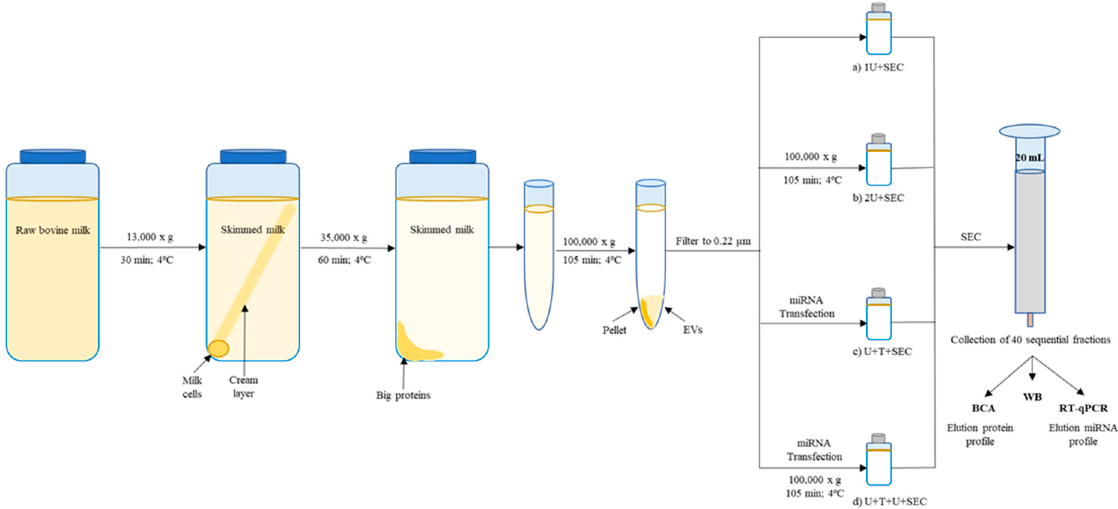
Figure 6. Summary of the EV isolation approaches. Raw bovine milk was skimmed by differential centrifugation to remove cells, fat globules and large proteins. Ultracentrifugation of 25 mL of skimmed milk (SM) results in a solid pellet containing most of the SM casein, a supernatant of milk serum, and a viscous phospholipid rich soluble concentrate positioned adjacent to the casein pellet containing EVs (called fluffy layer). EV fluffy layers were filtered through 0.22 µ m syringe filters. Afterwards, 700 µ L of filtered EVs were enriched through two different approaches: ( a ) SEC (1U + SEC) or ( b ) additional ultracentrifugation followed by SEC (2U + SEC). After first ultracentrifugation, EVs loaded with exogenous miRNA by the transfection method were then isolated by ( c ) SEC (U + T + SEC) or ( d ) additional ultracentrifugation followed by SEC (U + T + U + SEC). Forty sequential fractions of 500 µ L were collected and their miRNA and protein elution profiles were subsequently obtained by carrying out different methodology (BCA, Western Blot and/or RT-qPCR